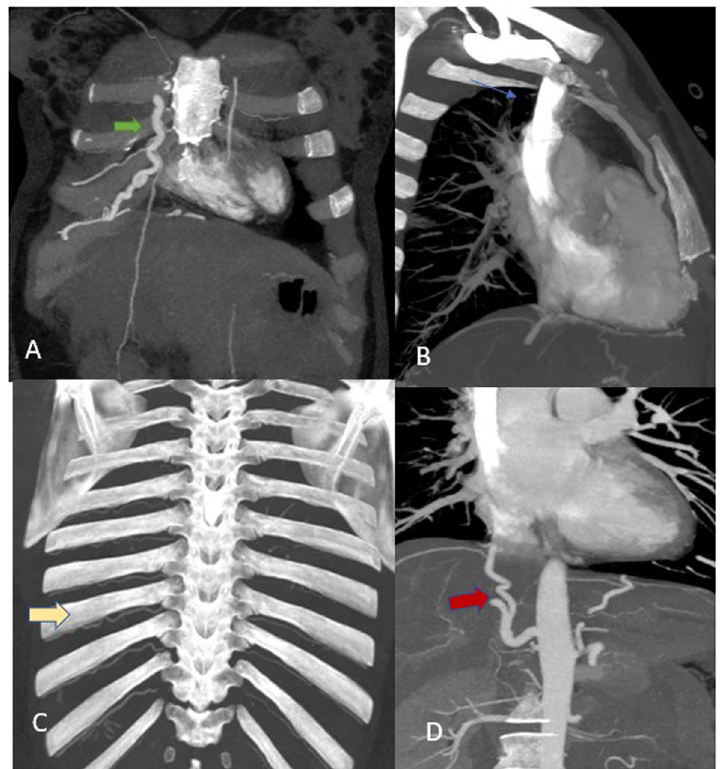
Fig. 5 CT Angiography MIP images (A- coronal, B- sagittal, C-D coronal) showing dilated right internal mammary artery (marked by green arrow), dilated right subclavian artery (marked by blue arrow), dilated posterior intercostal arteries (marked by yellow arrow) along posterior chest wall in right hemithorax and dilated inferior phrenic artery (marked by red